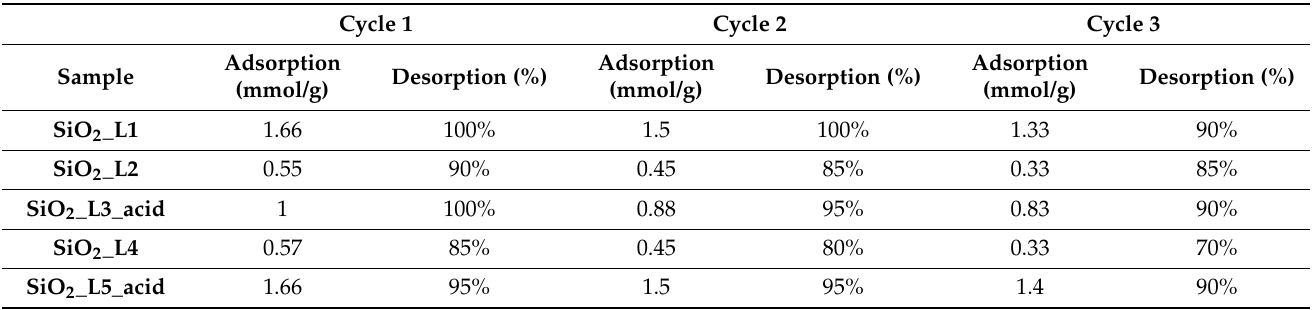
Table 5. Reusability of grafted SiO 2 NPs after 3 cycles of Ni adsorption and desorption tests. Cycle 1 Cycle 2 Cycle 3